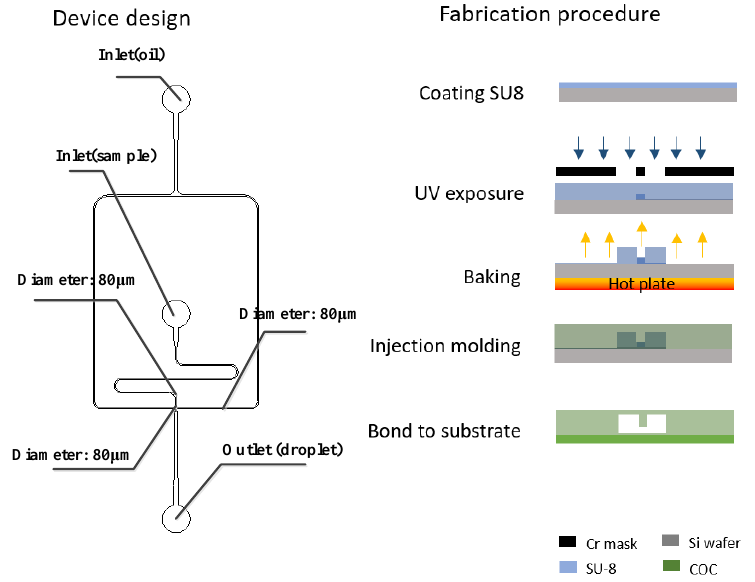
Figure 4. Design (left) and fabrication steps (right) of the microfluidic droplet Figure 4. Design and fabrication steps of the microfluidic droplet generator.